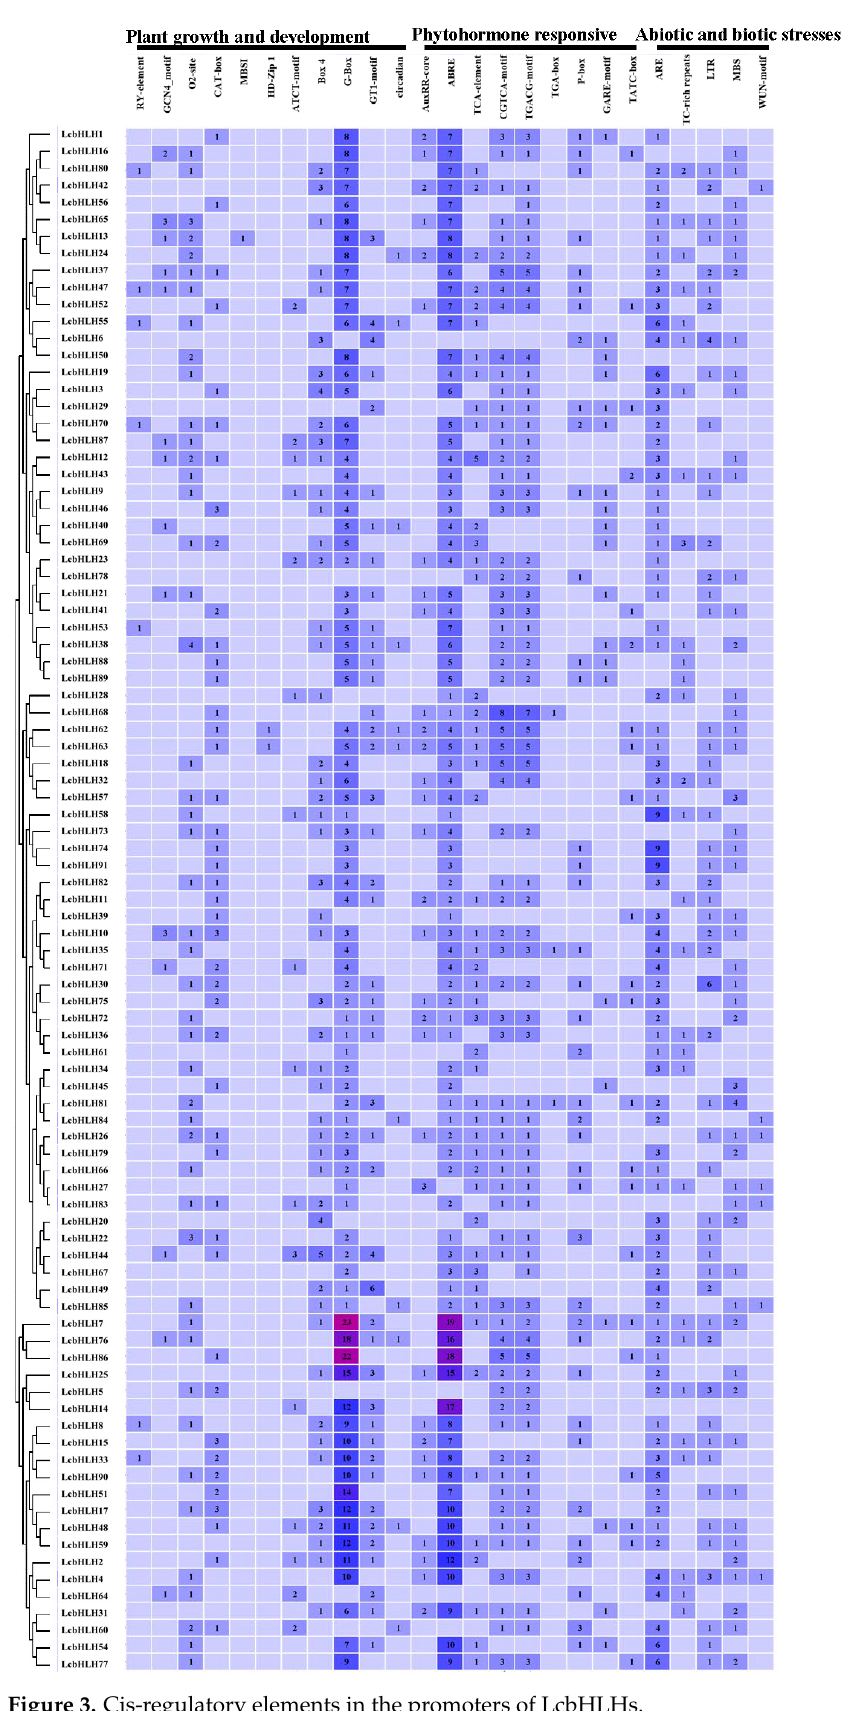
Figure 3. Cis-regulatory elements in the promoters of LcbHLHs.